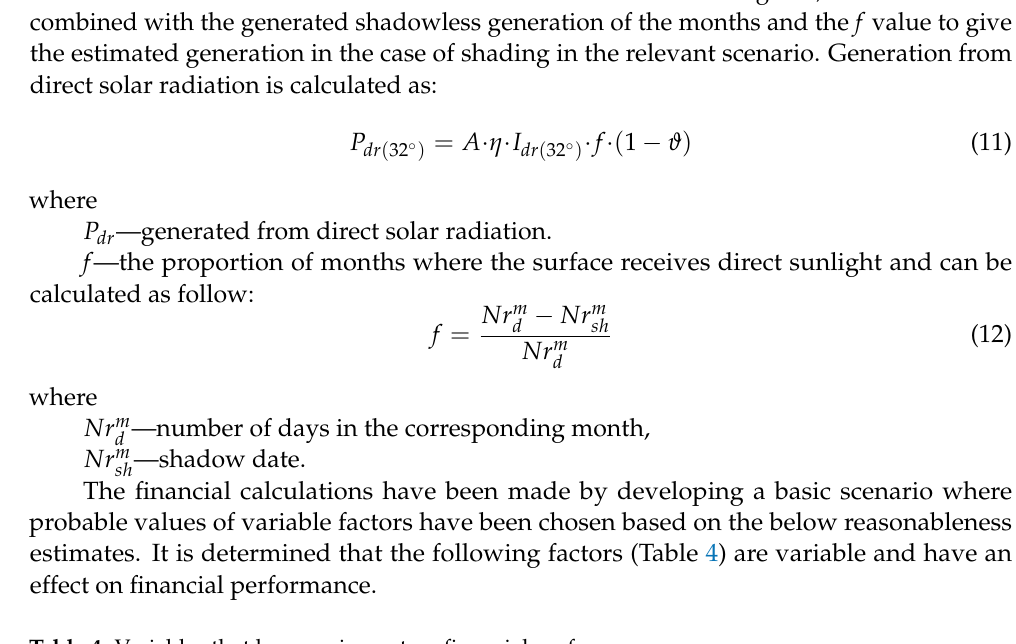
Table 4. Variables that have an impact on financial